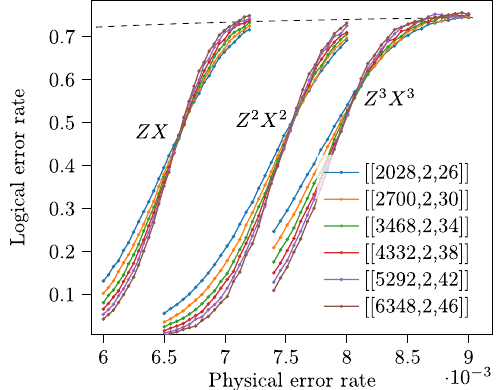
FIG. 12. Threshold plots for subsystem toric codes using a ð ZX Þ 92 schedule (left), ð Z 2 X 2 Þ 46 schedule (middle), and ð Z 3 X 3 Þ 31 schedule (right) using a depolarizing noise model.